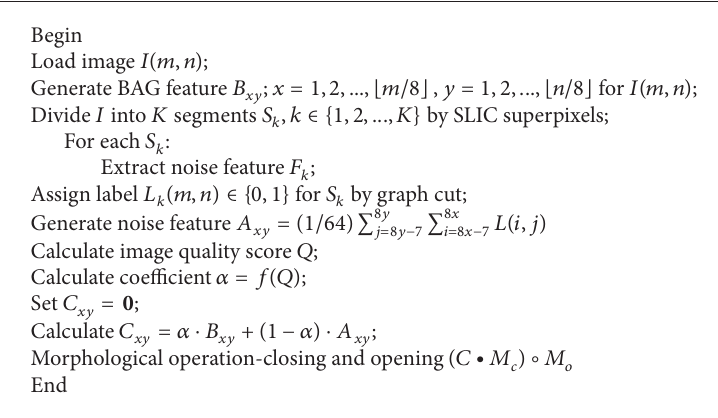
Algorithm 1: Algorithm description.